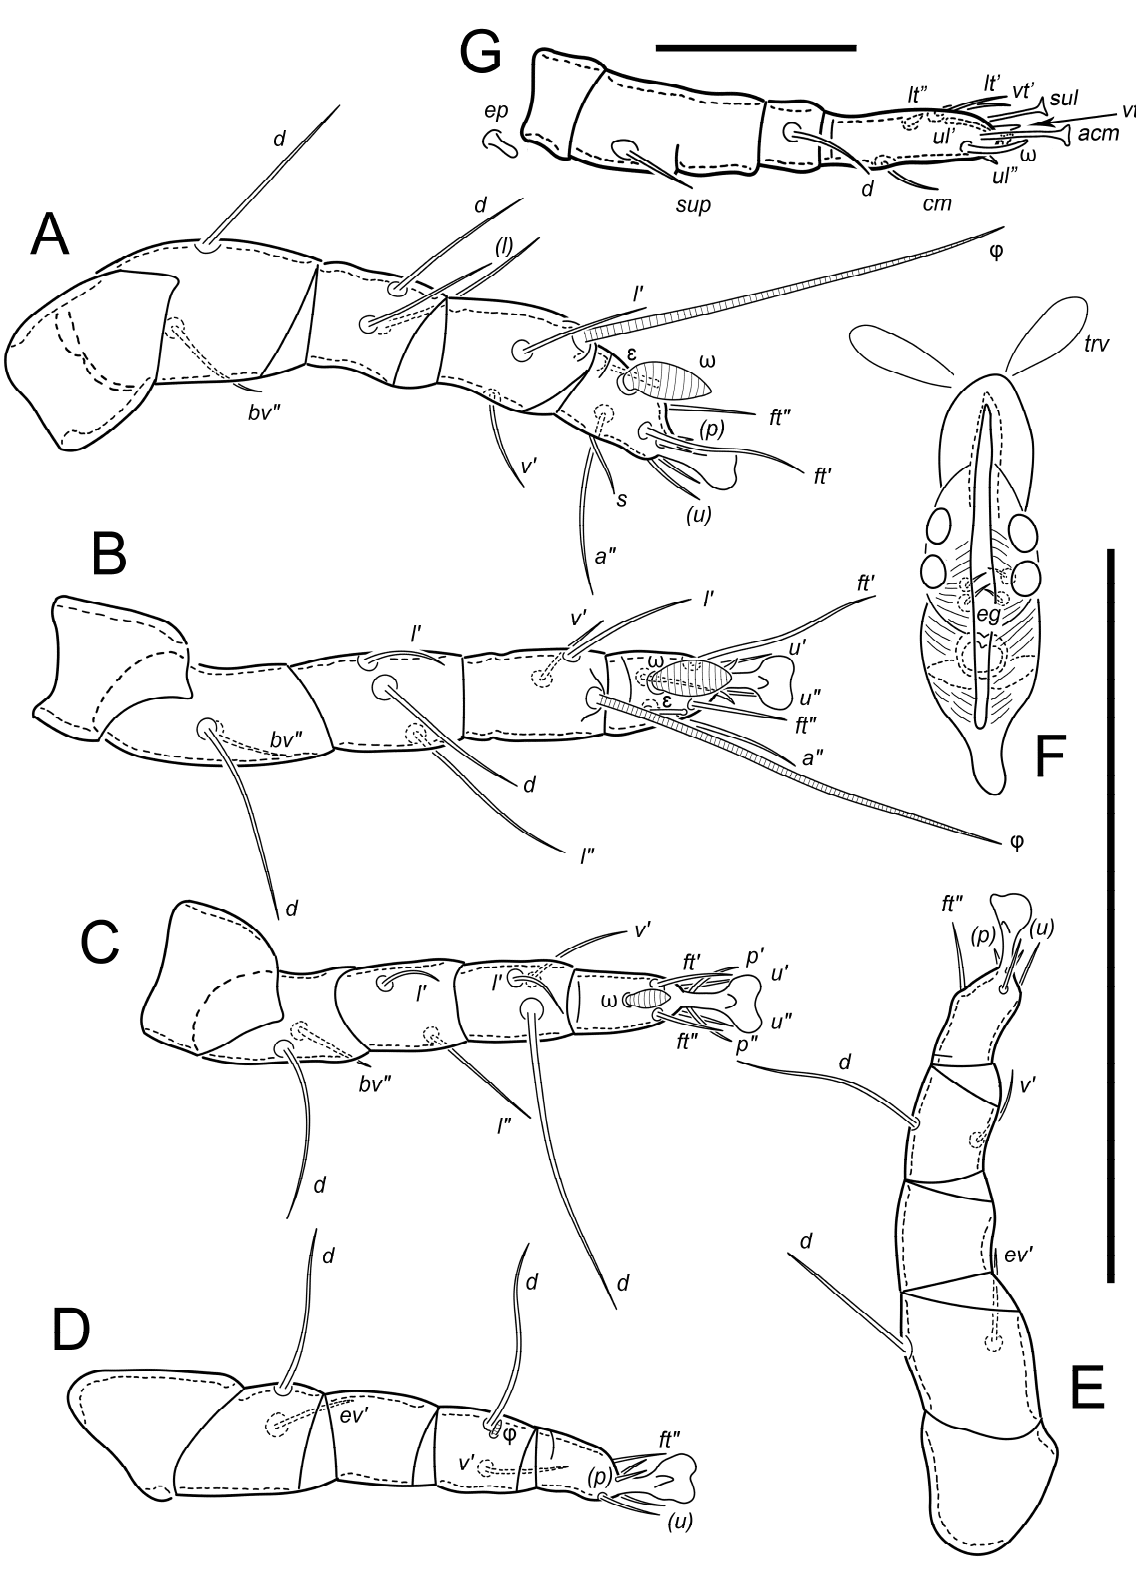
Figure 15. Paralycus persephone sp. n., female: ( A )—leg I, left, paraxial view; ( B )—leg I, right, dorsal view; ( C )—leg II, right, dorsal view; ( D )—leg III, right, paraxial view; ( E )—leg IV, right, paraxial view; ( F )—genitals; ( G )—palp, right, dorsal view. Scale bar 50 µm ( A – F ), 10 µm ( G ).